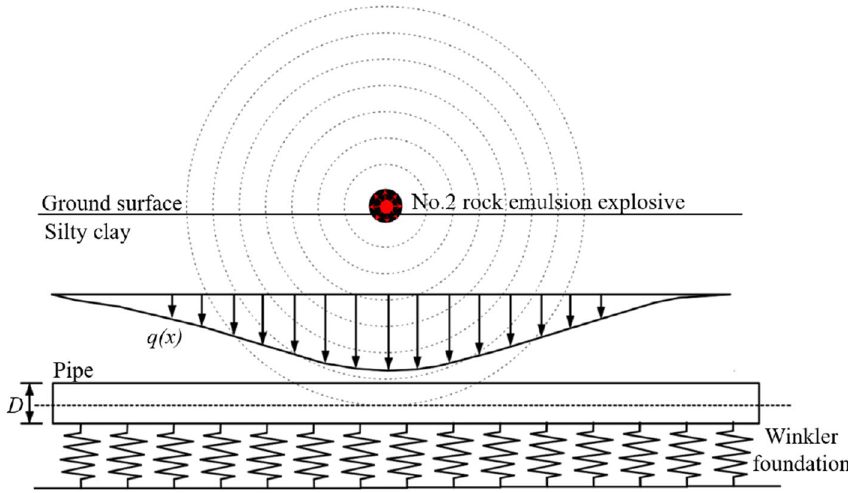
Figure 2. Calculation model for the impact on the pipeline.